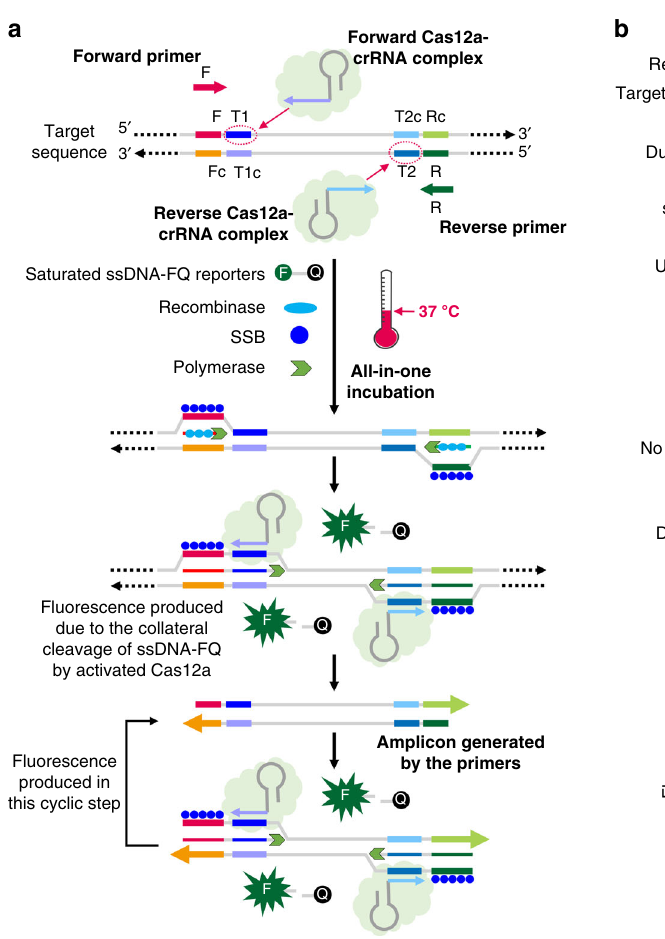
Fig. 1 Design and working principle of the AIOD-CRISPR assay. a Schematic of the AIOD-CRISPR assay system. SSB is single-stranded DNA binding protein. The four sites in the target sequence are labeled as F, T1, T2, and R, respectively. The letter c represents the corresponding complementary site. For example, F and Fc sites are complementary. The short horizontal lines with the same colors denote the same sites and their arrows represent the direction of 5 ′ – 3 ′ . b Evaluation of eight AIOD-CRISPR reactions (R) with various components through endpoint imaging after 40-min incubation, denaturing polyacrylamide gel electrophoresis (PAGE) analysis of the single-stranded fl uorescent reporter (ssDNA-FQ), and real-time fl uorescence detection. The ssDNA-FQ was labeled by 5 ′ 6-FAM (Fluorescein) fl uorophore and 3 ′ Iowa Black FQ quencher. Recombinase polymerase ampli fi cation (RPA) mix